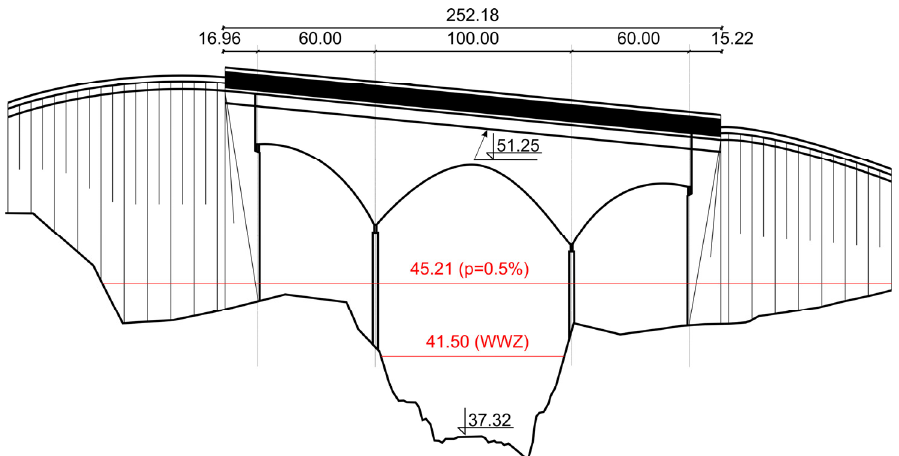
Figure 3. The chosen variant of the designed bridge at km 172 + 913 with upstream cross-section. The scheme without scale. All sizes and elevations are given in